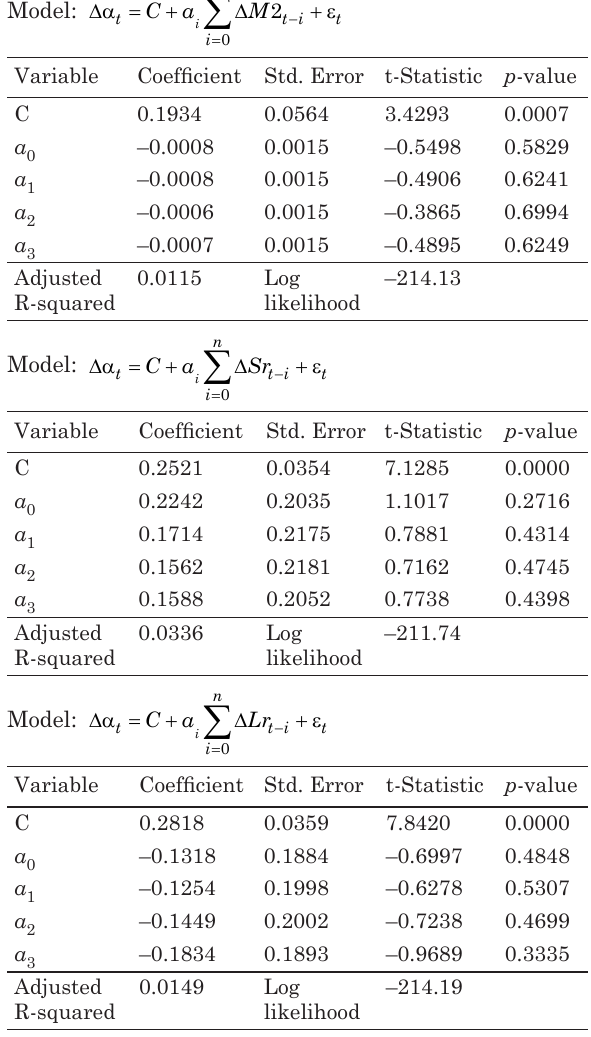
Table 6. Self-related behavior ( α